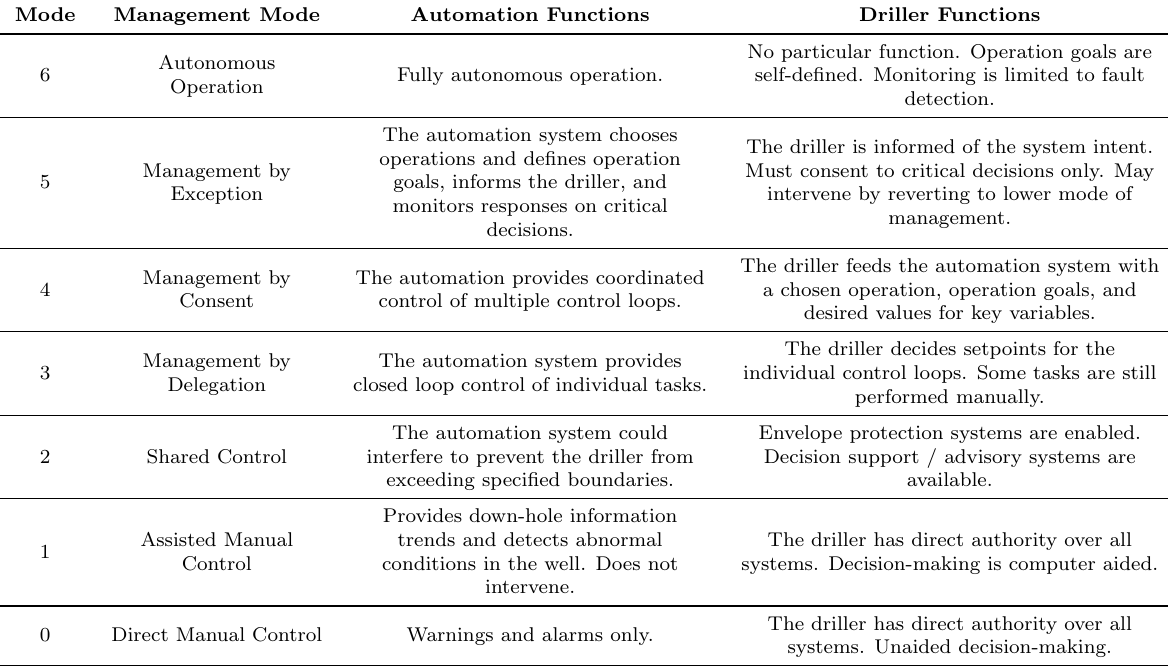
Table 1: Modes of automation (Breyholtz and Nikolaou,